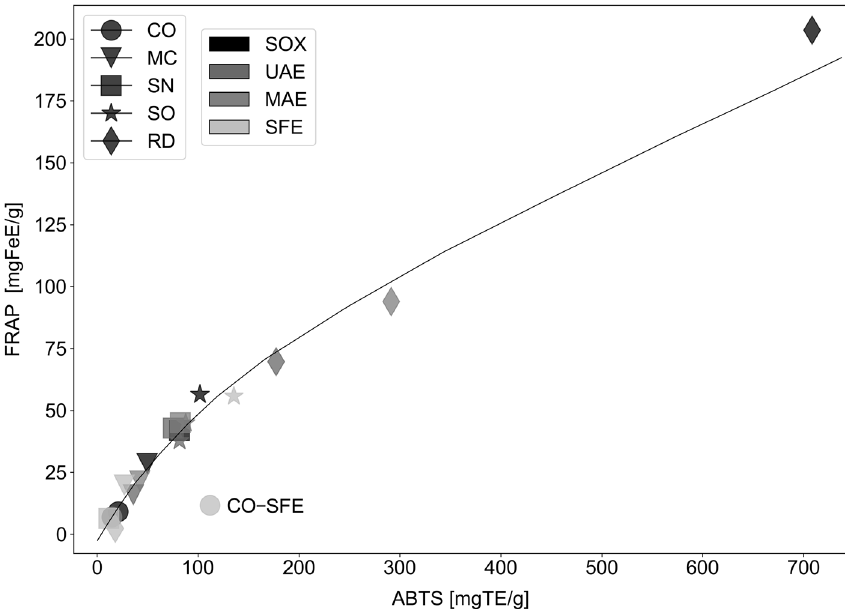
Figure 3. Correlation between FRAP and ABTS assays, showing a strong, but evidently non-linear interdependence. Additionally, FRAP assay appears to be far less sensitive to retinoid-type compounds, as evidenced by vastly out-of-trend position held by lipid-rich SFE extract obtained from Calendula officinalis (prepared using supercritical CO